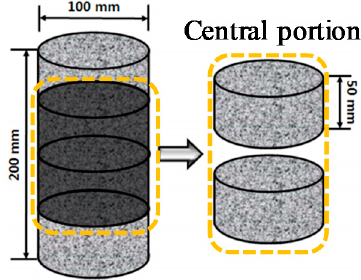
Figure 1. Schematic diagram of specimen for a chloride penetration test.